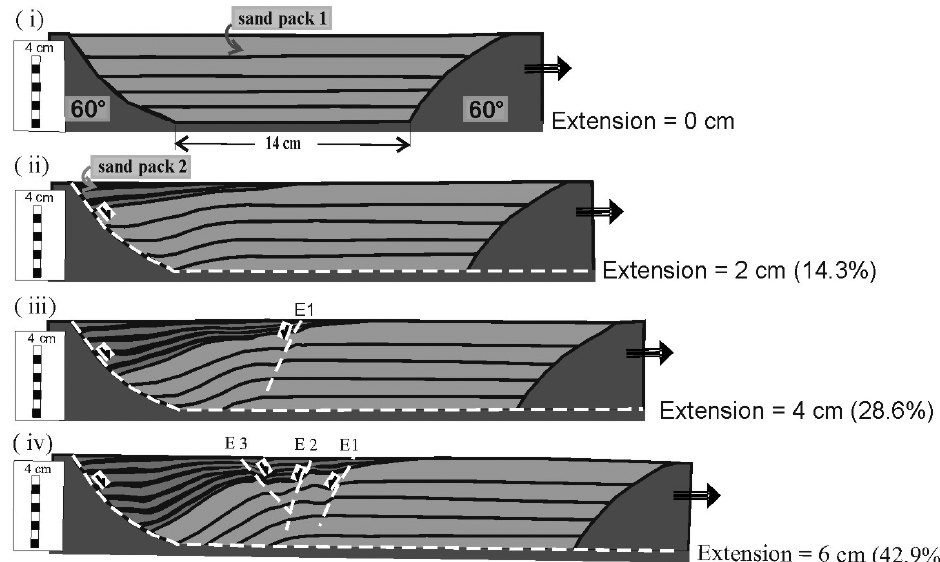
Fig. 3 – (i-iv) Sequential line drawings of extensional steps of photographs that were taken through the transparent sidewalls of model 1 ( α and β = 60 ◦ ) showing normal fault sequence E1-E3.